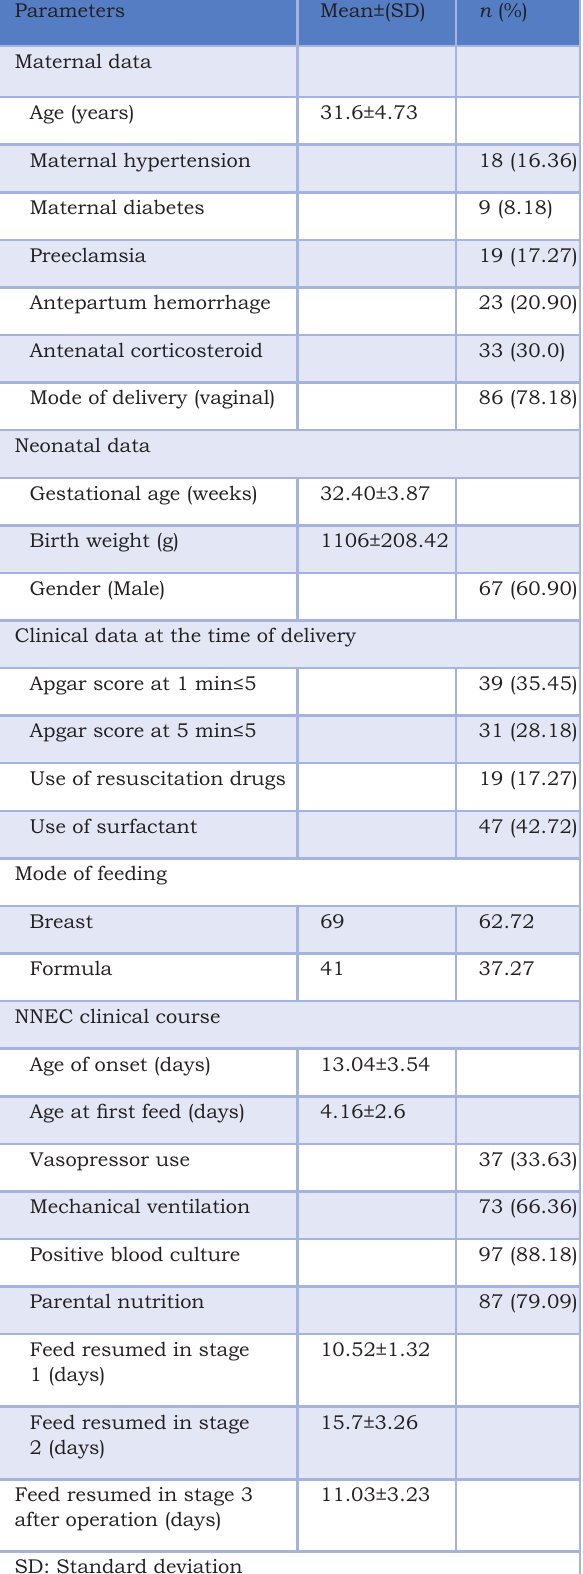
Table 1: Maternal and neonatal characteristics in neonates with NEC